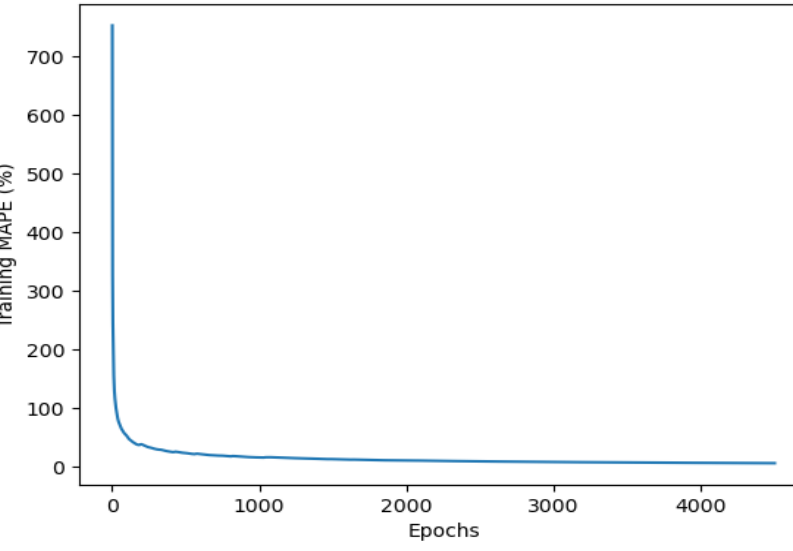
Figure 16. Final training MAPE of bimodal deep learning